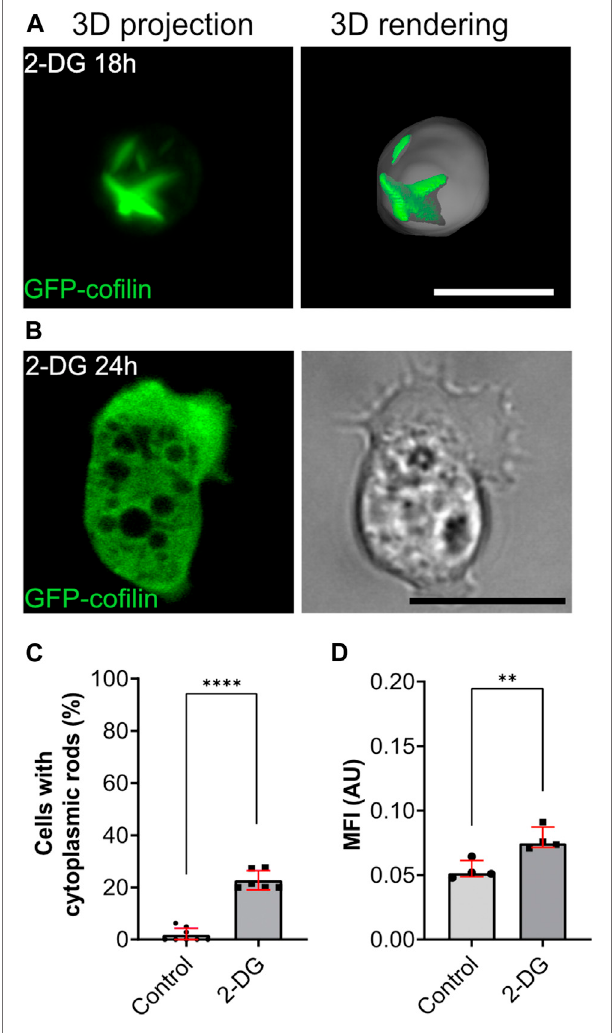
FIGURE 5 | Starvation induced by glucose-deprivation (2-DG) causes transient formation of cytoplasmic actin-co fi lin rods. (A) 3D projection and rendering of GFP-co fi lin expressing cells treated with 2-DG for 18 h, or (B) 24 h. Scale bars, 10 µm. (C) Percentage of cells with cytoplasmic rods after 18 h of glucose deprivation. For each experiment, 10x images (212 × 212 µm) were used for quanti fi cation ( n (cid:2) 6). (D) Ratiometric pH measurements 18 h after incubation of cells in 2-DG-containing medium. For eachexperiment,10ximages(212 × 212 µm)withatotalofmorethan20cells perexperimentwereanalyzedtodeterminethemeanof fl uorescenceintensity ( n (cid:2) 4). Error bars are median with interquartile range (red). Samples were considered signi fi cant when p ≤ 0.05. Welch´s t-test was applied.